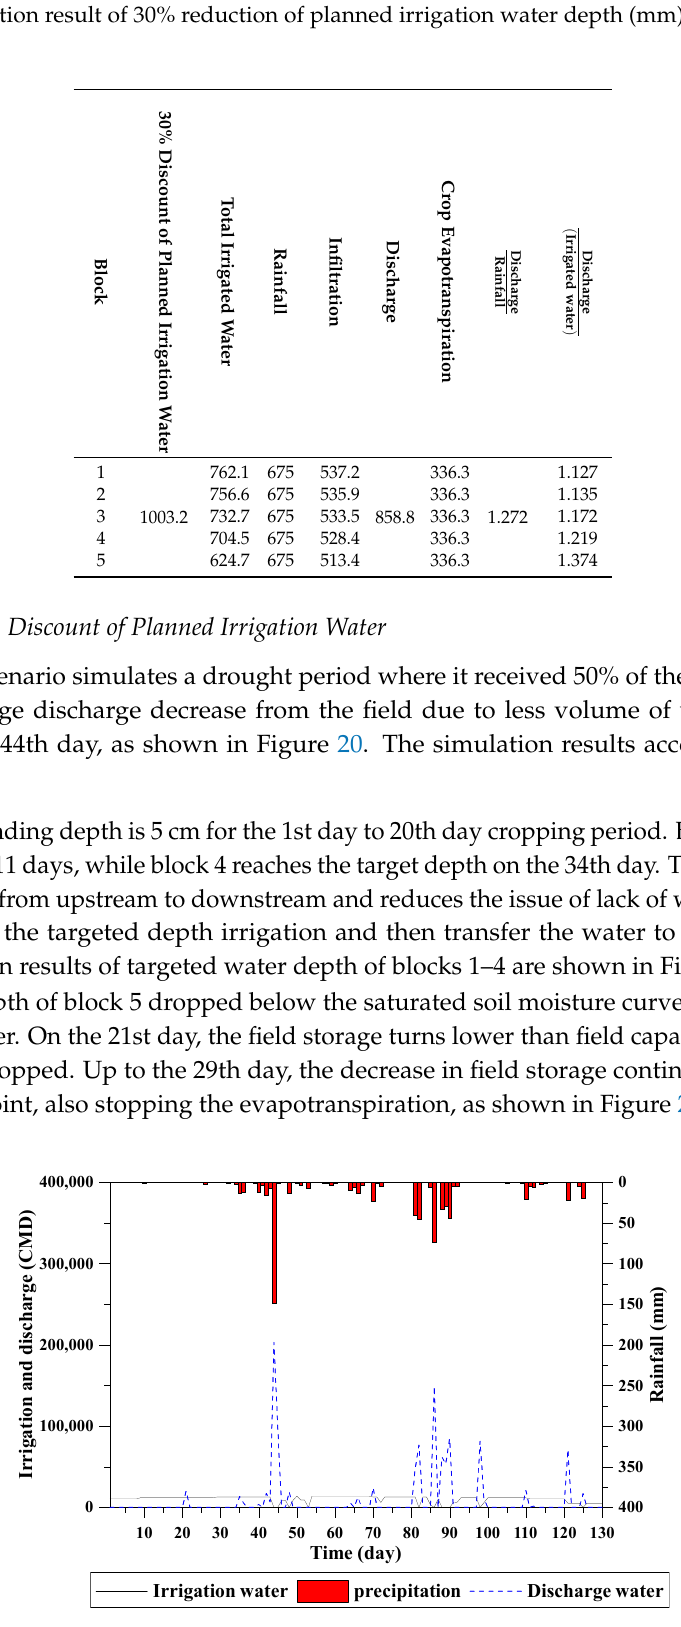
Figure 20. Irrigation, discharge, and rainfall simulation result for 50% reduction of the planned irrigation water during first crop season.